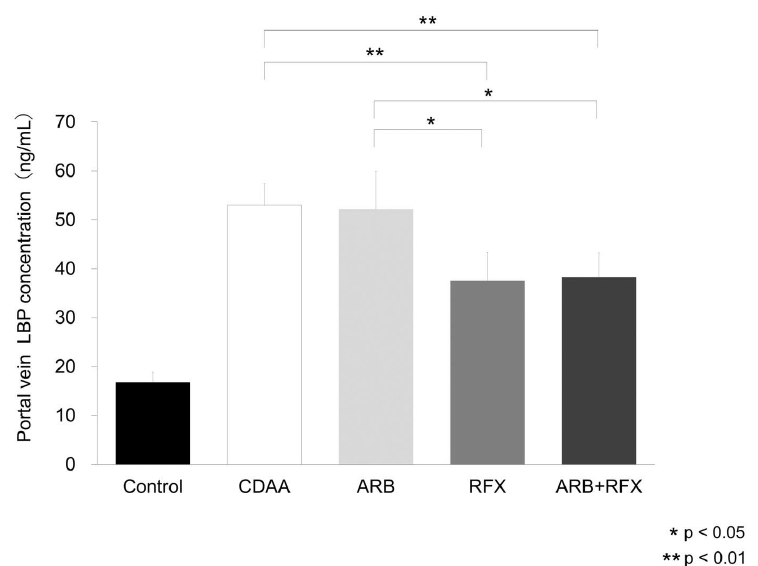
Figure 4. Evaluation of portal vein LPS-binding protein (LBP) concentration. LBP concentrations